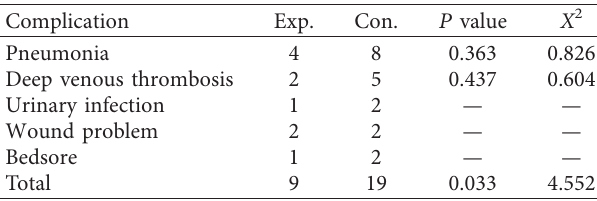
Table 5: Comparison of complications in both experiment and control groups.